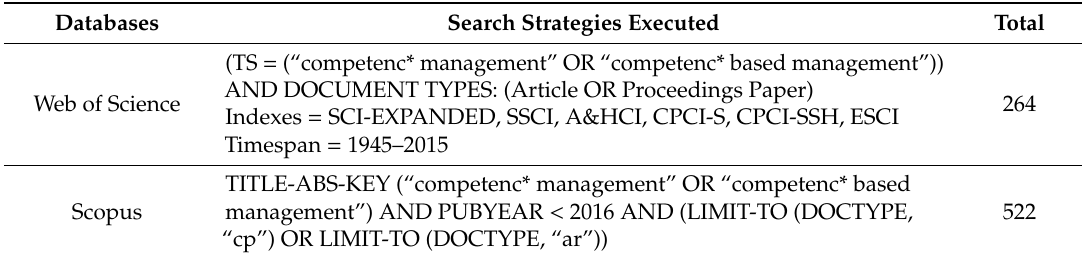
Table 3. Strategies of search conducted, and the results obtained in Web of Science and Scopus databases.